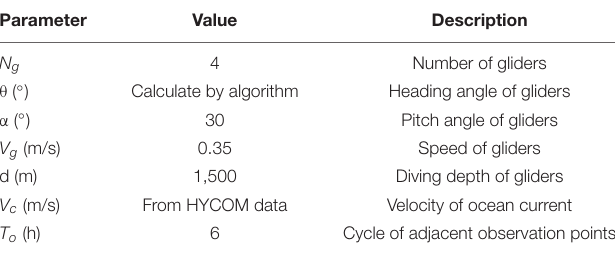
TABLE 1 | Several parameters of gliders were set in the simulation experiment.